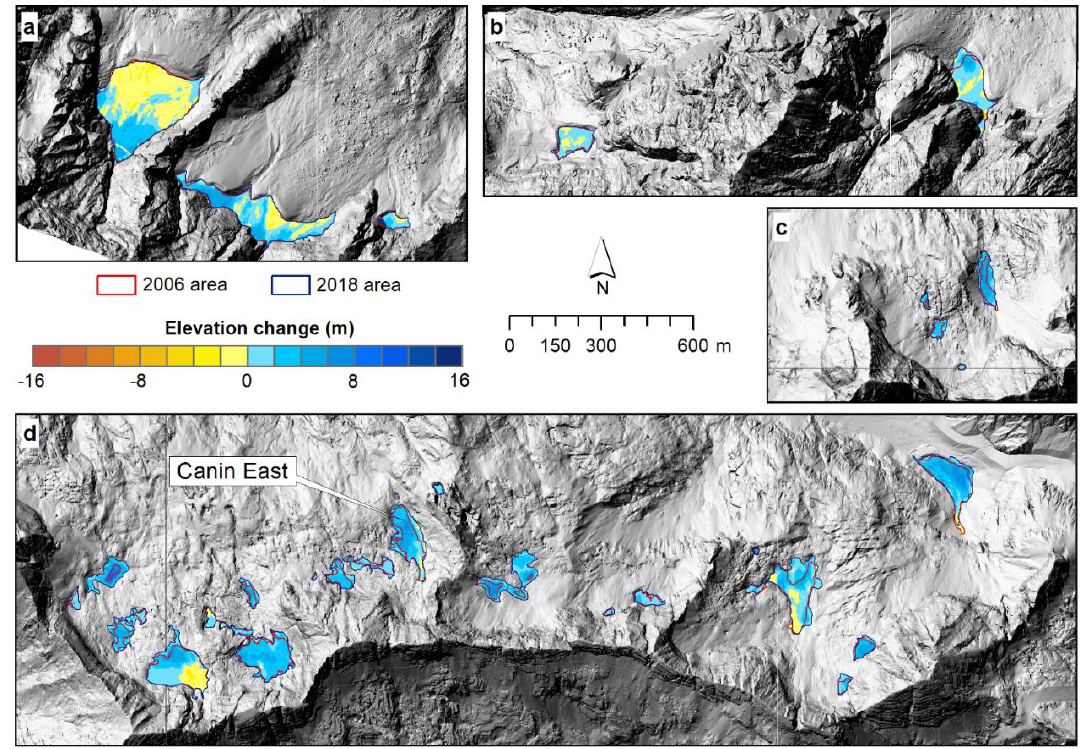
Figure 5. A 12-year (2006–2018) surface elevation change of all the ice bodies in the Italian Julian Alps (see colored bar for elevation changes). ( a ) Montasio sector. ( b ) Carnizza-Riofreddo-Studence sector. ( c ) Cergnala sector. ( d ) Canin sector.